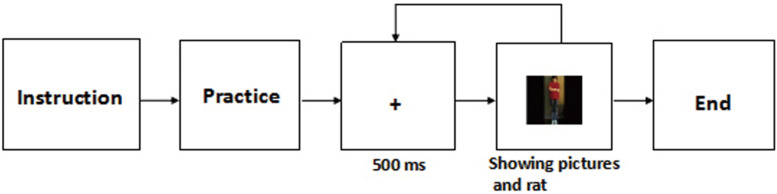
The procedure of emotional feelings rating.